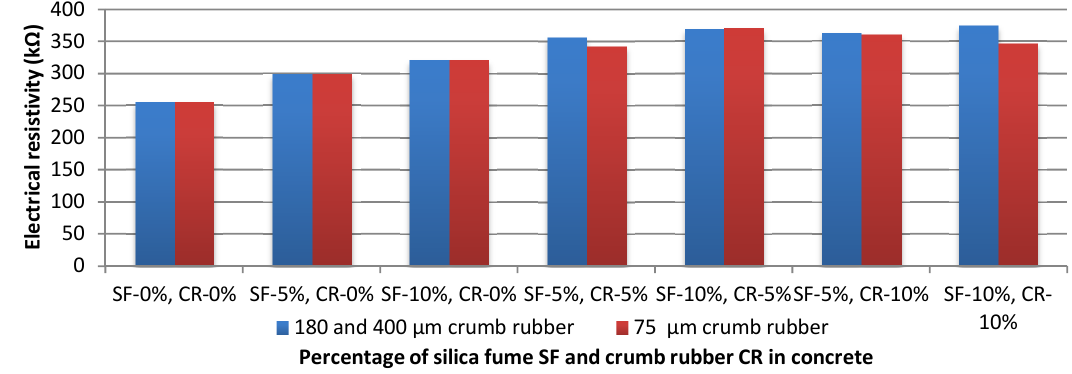
Figure 14. Electrical resistivity of rubber concrete with different particles size.